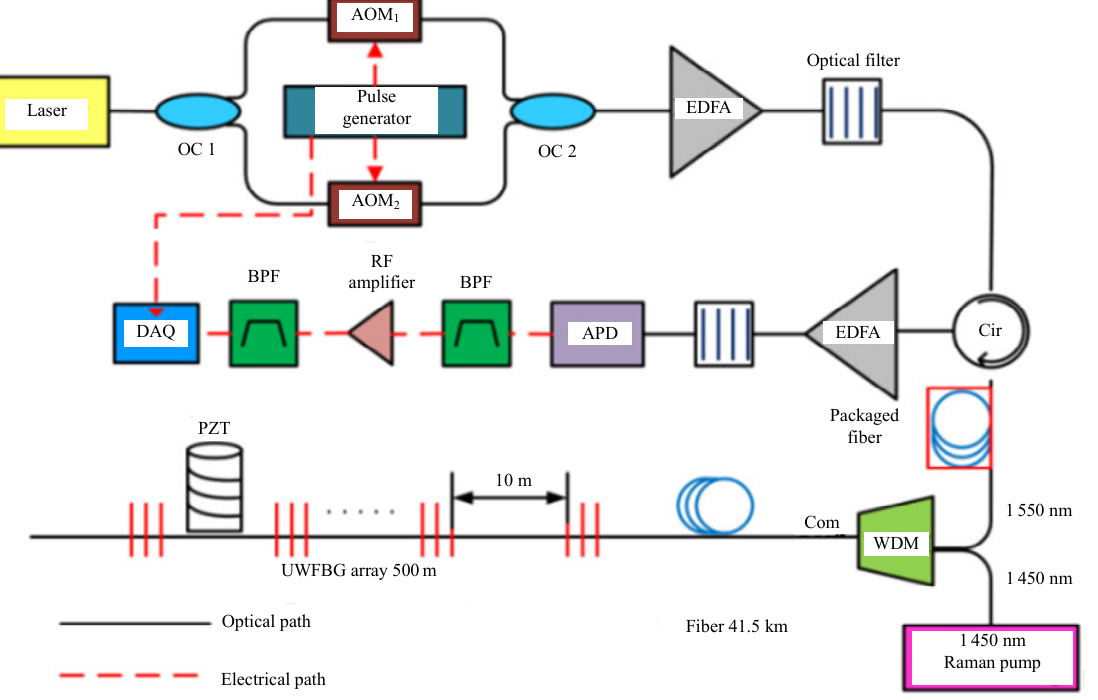
Fig. 13 Schematic diagram of the system based on the UWFBG array and self-heterodyne detection